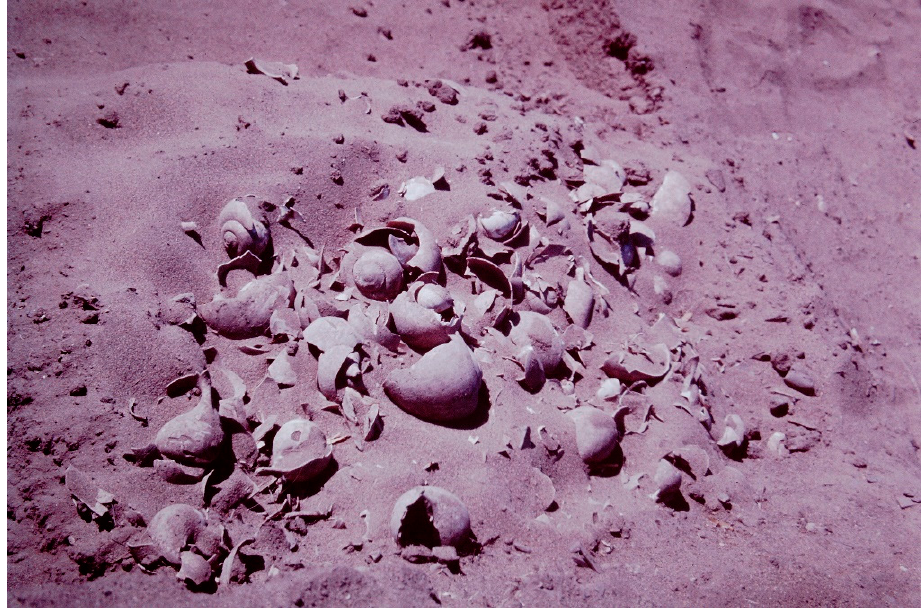
Figure A5. Mesolithic shell midden on the surface of a sand dune in the lower White Nile valley. The site was occupied at least seasonally about 8000 years ago. For details, see [83].